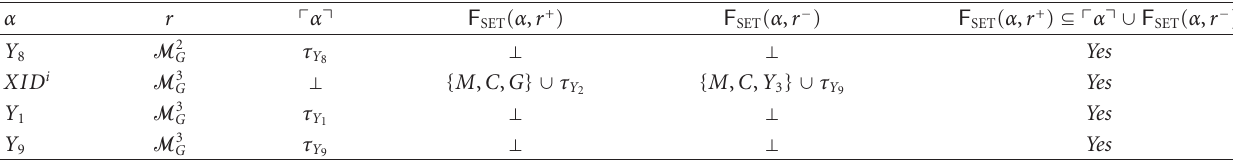
Table 19: SET analysis: role of M .